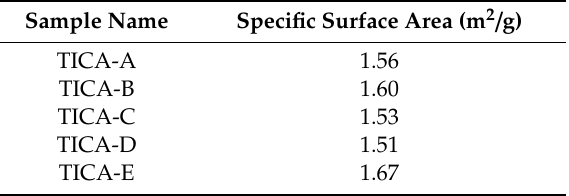
Table 5. Specific Surface Area of TICA crystal